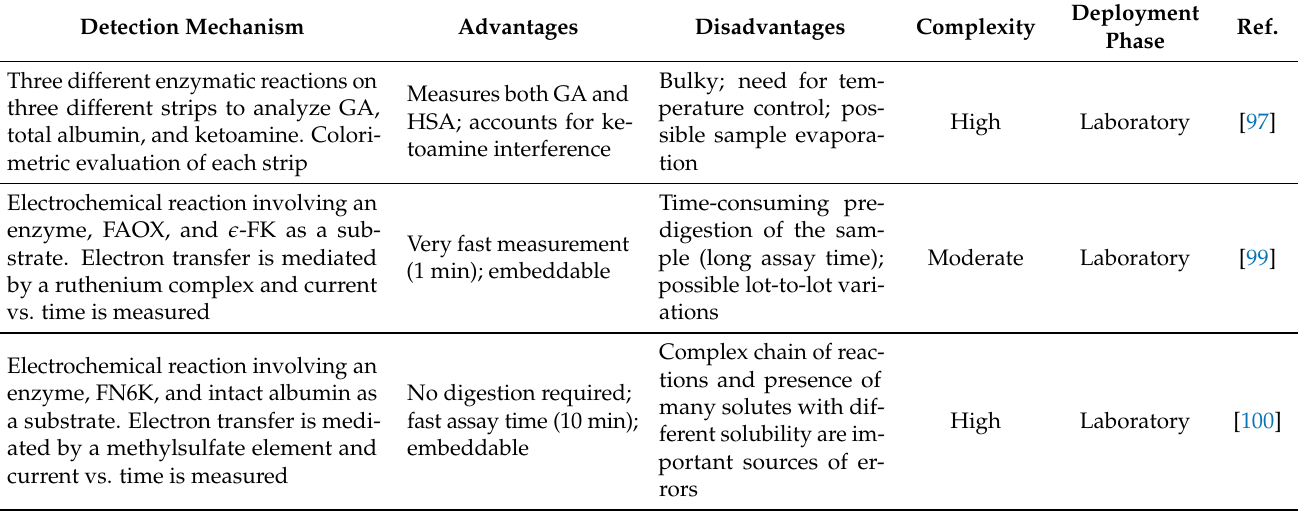
Table 3. Enzymatic biosensors comparison. The ‘Complexity’ column indicates qualitatively the difficulty of the manufacturing process for a specific solution. The ‘Deployment phase’ column indicates at which level the technology is actually adopted: ‘Laboratory’ suggests an ad-hoc experi- mental phase, ‘Pre-clinical’ specifies that the biosensor has been tested on real patients samples in a controlled